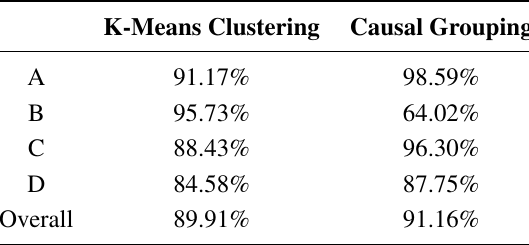
Table 5. The classification accuracy for the intersection dataset.